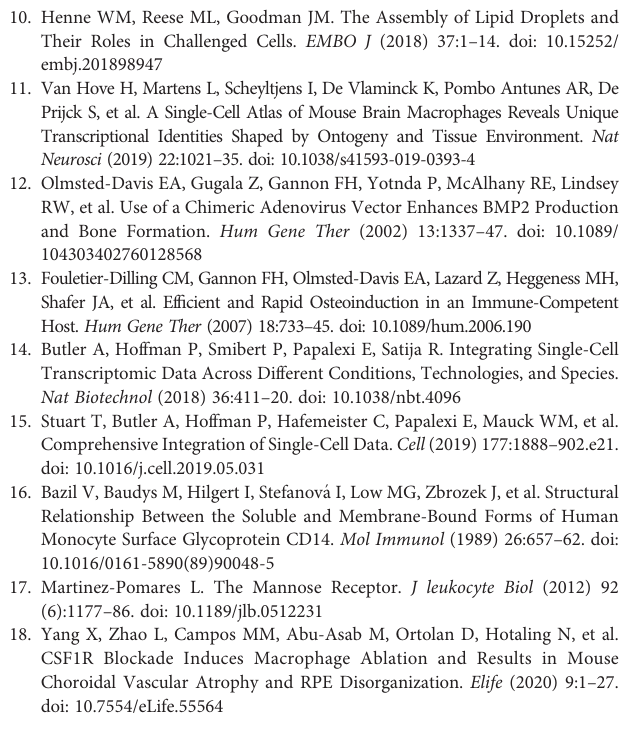
Supplementary Figure 1 | Immunohistochemisty for Cd14 and Adrb3 in mouse lungs. Mouse lungs were infected with 5 x 10 12 AdBmp2. After 4 days the mice were euthanized. The lungs were fi xed in formalin and then embedded in paraf fi n. Sections were stained with both anti Cd14 (green) and anti Adrb3 (red).